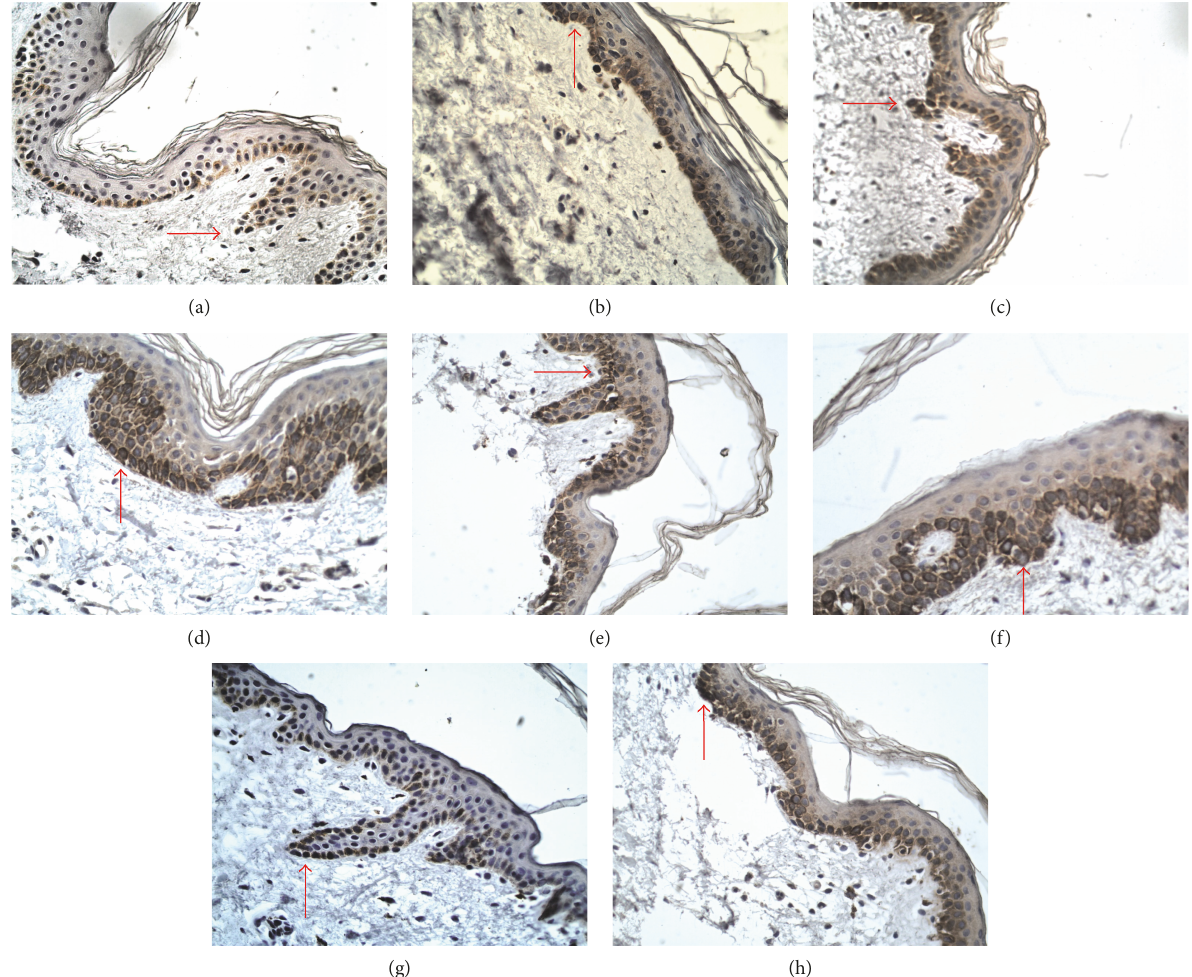
Figure 4: Immunoexpression of JAK/STAT proteins in epidermis, BP, 400x, immunohistochemistry. Immunoexpression of JAK3 in epidermis (a) perilesional skin 12.54 ± 2.99 and (e) skin lesions 18.19 ± 5.58, p > 0 05 ; immunoexpression of STAT2 in epidermis (b) perilesional skin 14.01 ± 2.38 and (f) skin lesions 17.32 ± 2.69, p > 0 05 ; immunoexpression of STAT4 in epidermis (c) perilesional skin 21.05 ± 2.91 and (g) skin lesions 25.13 ± 3.56, NS; immunoexpression of STAT6 in epidermis (d) perilesional skin 17.46 ± 2.41 and (h) skin lesions 26.09 ± 4.45,